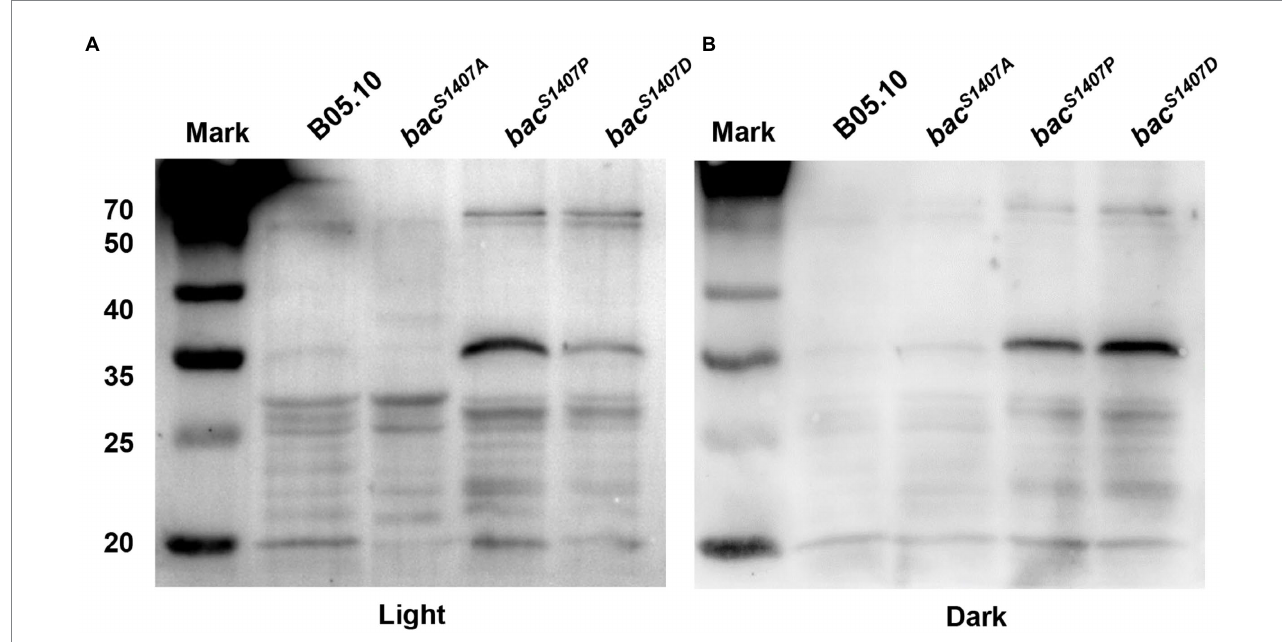
FIGURE 3 Differences in phosphorylation levels of total proteins of mycelia of wild-type (B05.10) and mutation strains ( bac S1407P , bac S1407A , and bac S1407D ) growing for 3 days on CM under light (A) and dark (B)